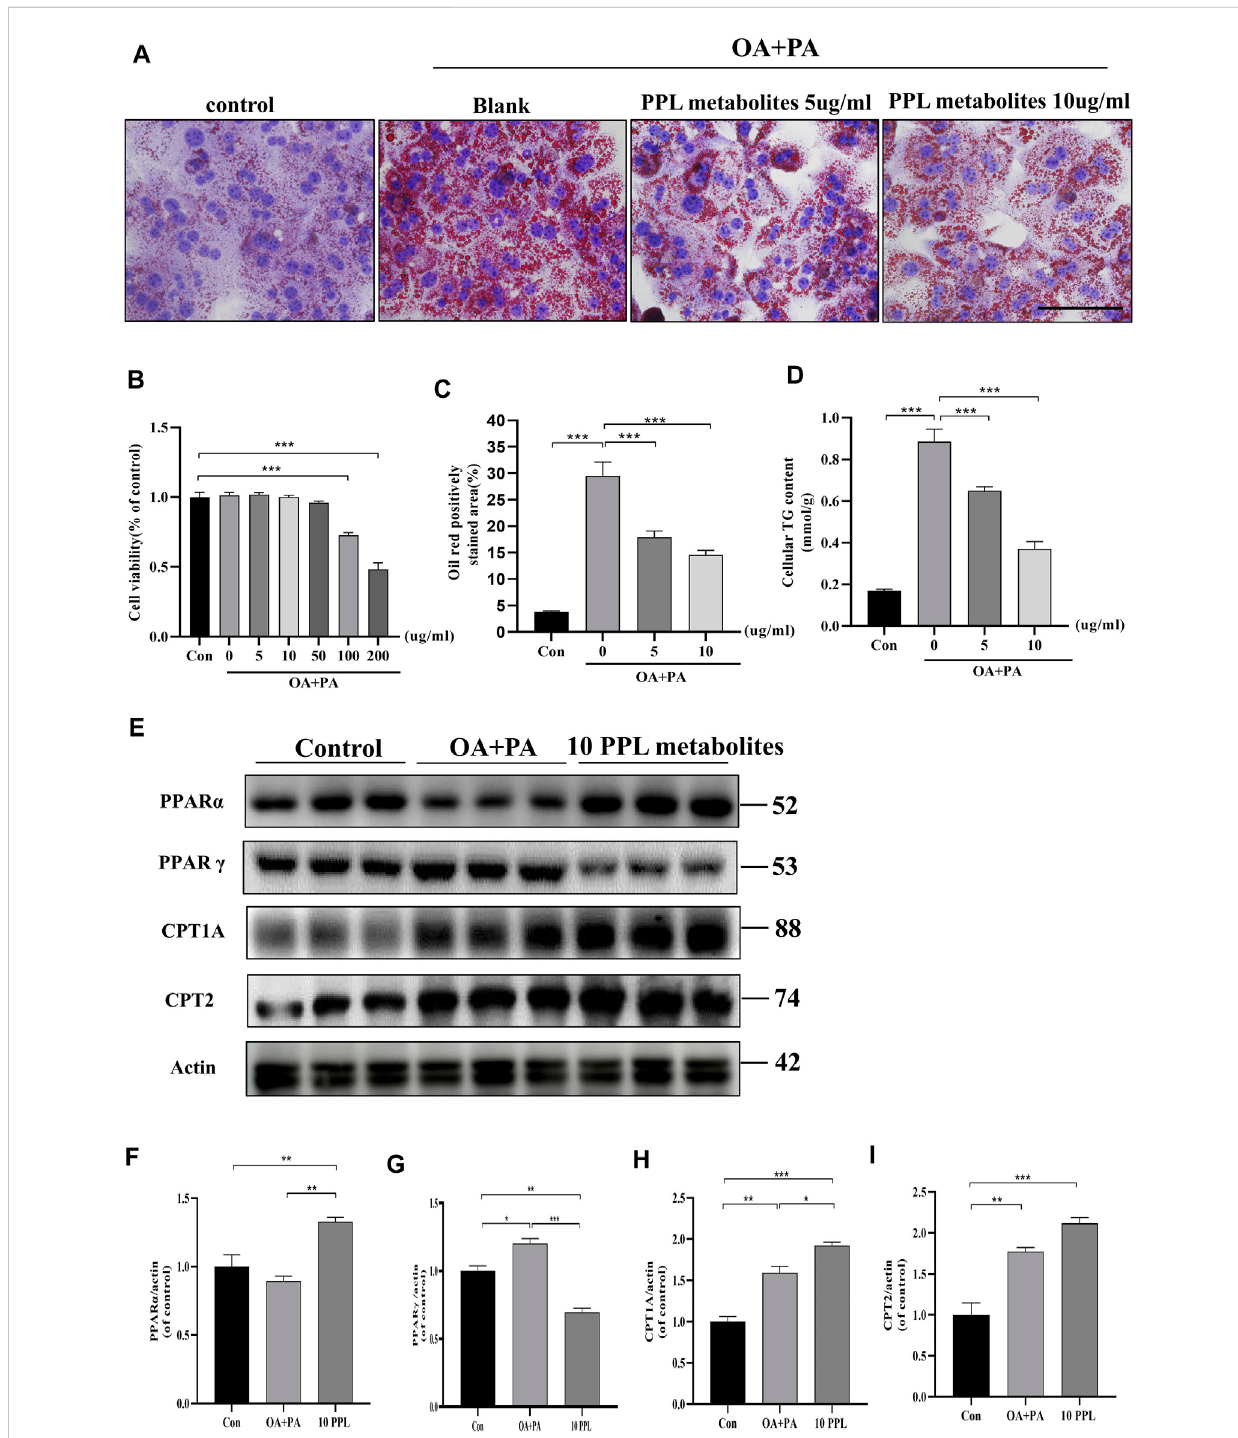
FIGURE 6 The anti-lipid deposition effect of PPL metabolites in PA/OA-treated mice primary hepatocytes. (A) Oil Red O staining of PA/OA-induced lipid accumulationinprimaryhepatocytesaftertreatingwithPPLmetabolites. (B) CellviabilitywasdetectedbyCCK8afterprimaryhepatocytesincubatedwith PPLmetabolitesandtreatedwithPA/OAfor24 h(n=10pergroup). (C) OilredOpositivelystainedareawasshownfromeachgroup(n=7pergroup). (D) AmountofcellularTGwasdetectedfromdifferentgroupaftertreatment(n=4pergroup). (E) TheexpressionlevelofproteinsPPAR α ,PPAR γ ,CPT1A and CPT2 in theprimary hepatocytes were analyzed by immunoblotting(n =3 per group). (F – I) The quantitative densitometricanalysisof PPAR α , PPAR γ , CPT1A and CPT2. Magni fi cation: ×400, scale bar: 100 μ m. Data were expressed as the mean ± SEM. Differences among groups were compared by one- way ANOVA. * p < 0.05, ** p < 0.01, *** p <